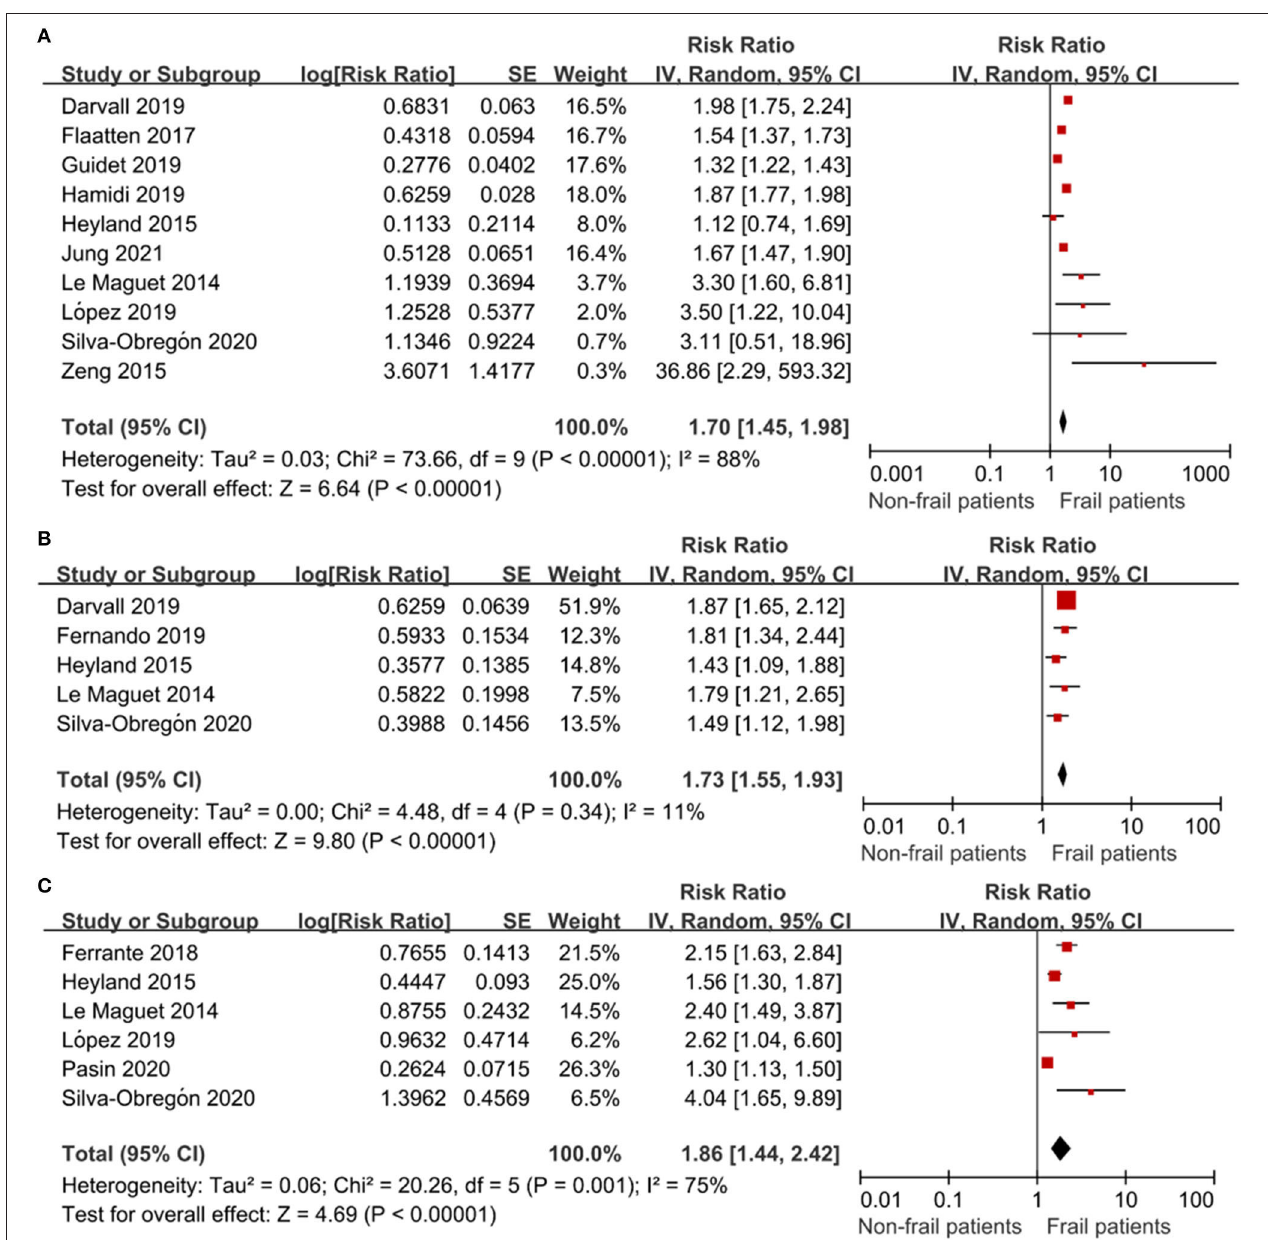
FIGURE 3 | The association of frailty and mortality in elderly patients admitted to ICU. RR = relative risk. (A) The association of frailty and short-term mortality in elderly patients admitted to ICU. (B) The association of frailty and in-hospital mortality in the elderly patients admitted to ICU. (C) The association of frailty and long-term mortality in the elderly patients admitted to